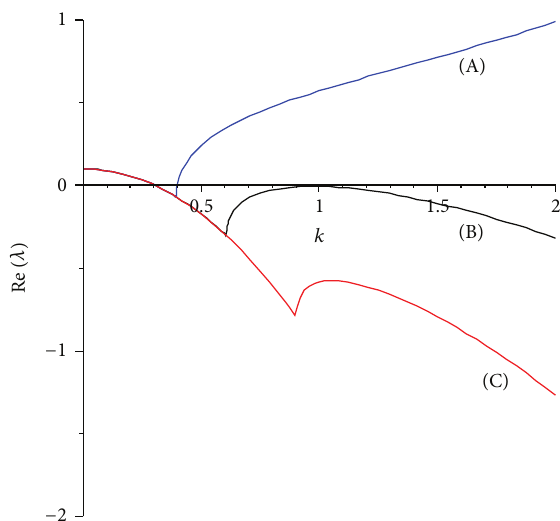
Figure 2: Model (5) with wavenumbers lying between the zeros of 𝑘 2 𝐺(𝑘 2 ),𝑘 2 − , and + growing in the Turing instability. Parameters are taken as 𝛼 = 1.11 , 𝛽 = 0.1 , 𝛾 = 11.25 , 𝛿 = 0.36 , 𝐷 11 = 0.2 , 𝐷 22 = = −0.5 , and 𝐷 = −0.4 ; hence, 𝑘 2 2 , 𝐷 12 21 = −0.283261256 . 2.807586678 , and 𝐺 min